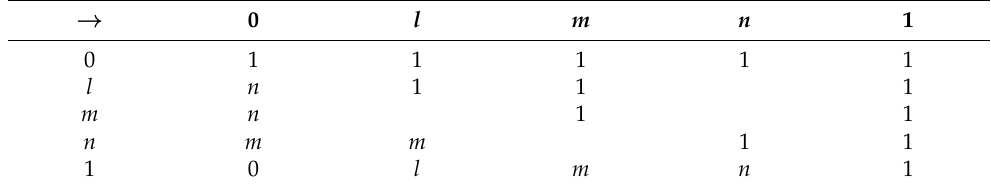
Table 10. The partial operation →